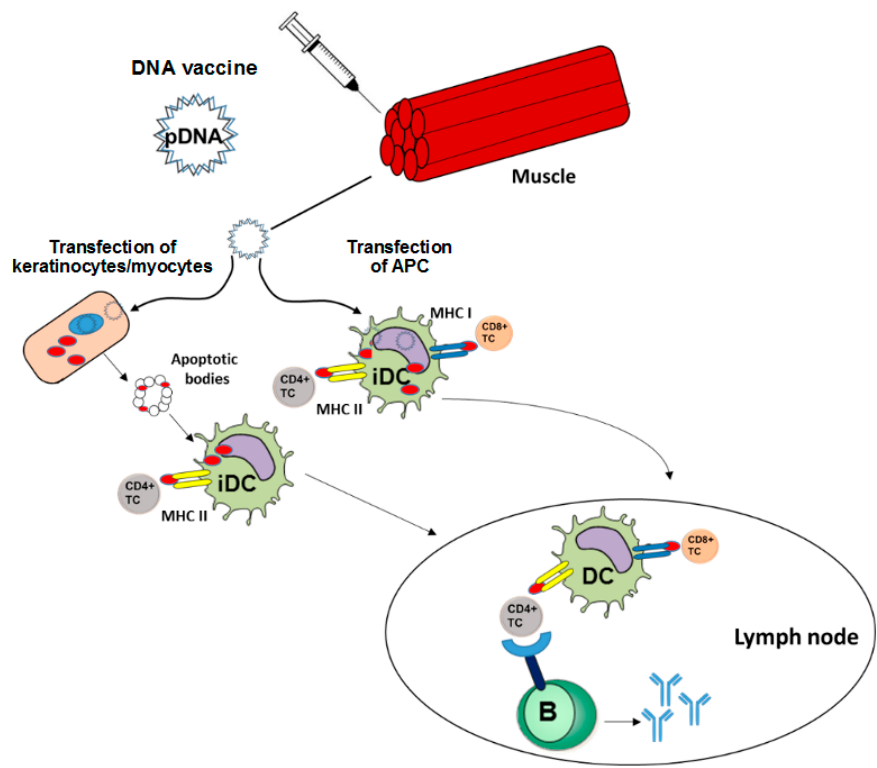
Figure 1. DNA vaccines induce adaptive immune responses. A DNA vaccine intended to induce an adaptive immune response needs to encode an antigen and an adjuvant. The according plasmid DNA is applied either systemically or topically, e.g., by intramuscular injection. Transfected keratinocytes or myocytes express transgene and release derived peptide/protein via exosomes or apoptotic bodies. This material is endocytosed by immature dendritic cells (iDC) which subsequently present antigen preferentially via major histocompatibility class (MHCII) to CD4 + T cells in draining lymph nodes. Direct transfection of APC including iDC results in endogenous transgene expression, and hence parallel presentation via MHCI and MHCII, yielding CD8 + and CD4 + T cell responses in parallel. Besides this cellular immune response, a humoral immune response is induced if the B cell receptor recognizes the protein antigen, and acquires help by pre-activated antigen-specific CD4 + T cells.